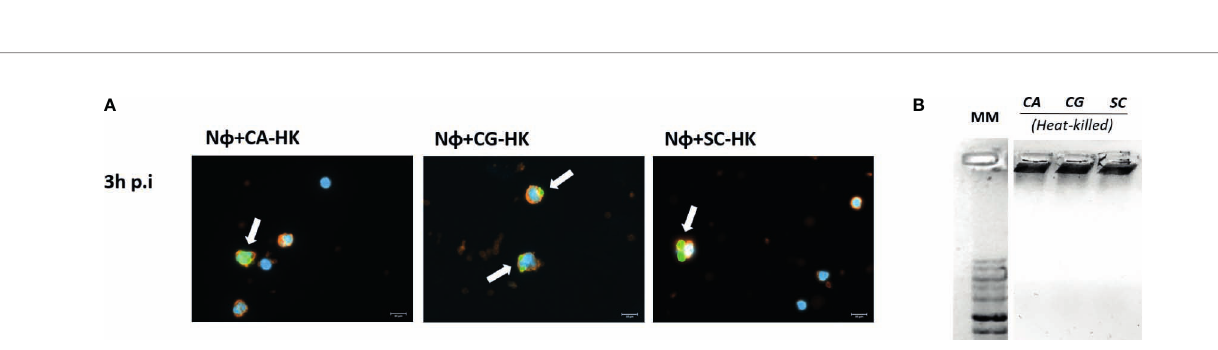
FIGURE 7 | Candida albicans viability upon neutrophils interaction. C. albicans (CA) colony forming unit (CFU) assays were performed at 1 h post infection, upon different conditions: neutrophils with CA (N ɸ +CA) and neutrophils with CA, stimulated with PMA (N ɸ +CA+PMA) or TTM (N ɸ +CA+TTM). Colonies were counted after 3 days, and the data represent at least three independent experiments (means ± SEM).